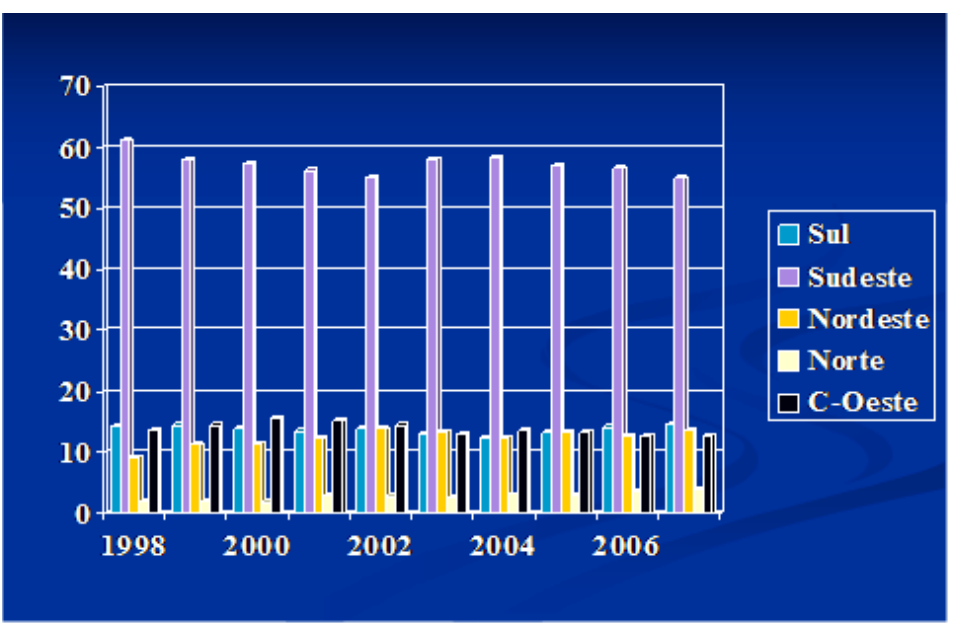
Figura 2 . Percentual de docentes da pós-graduação que receberam bolsas de produtividade em